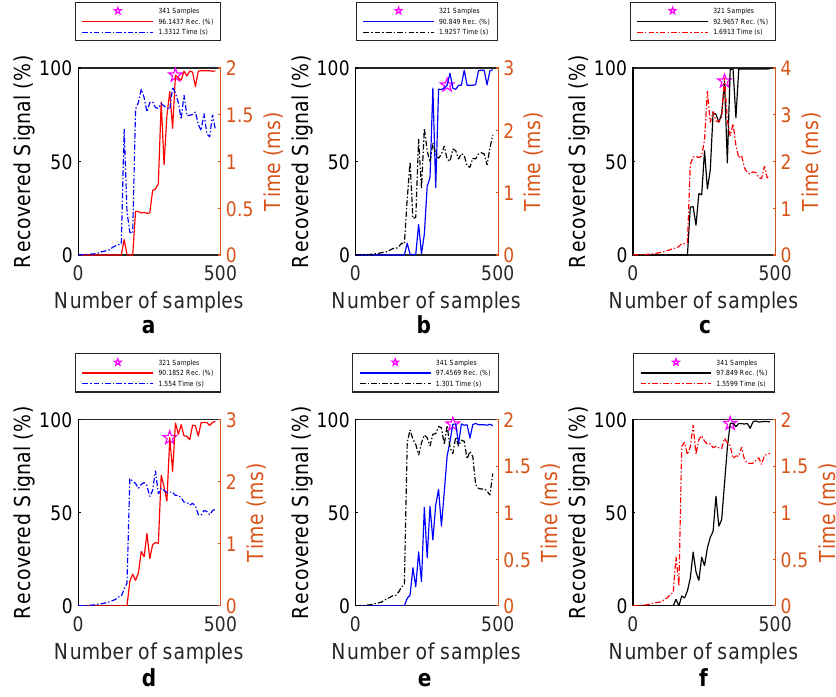
Figure 9. Number of m samples needed to recover the signal vs processing time (( a – c ) current and ( d – f ) voltage at bus